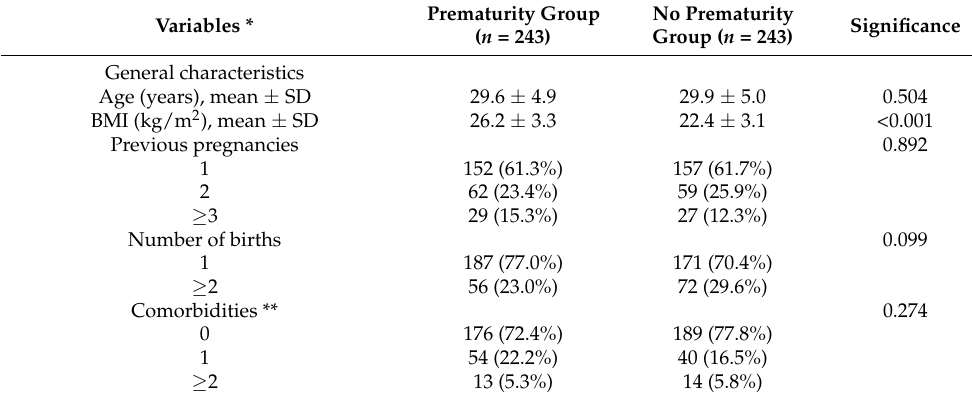
Table 1. Background characteristics of the patients analyzed in the